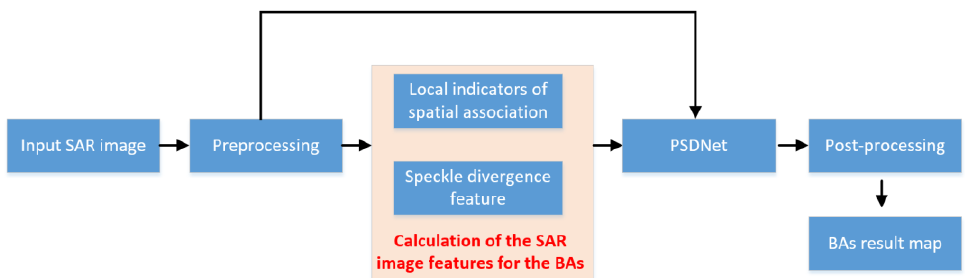
Figure 2. Flowchart of the proposed methodology.